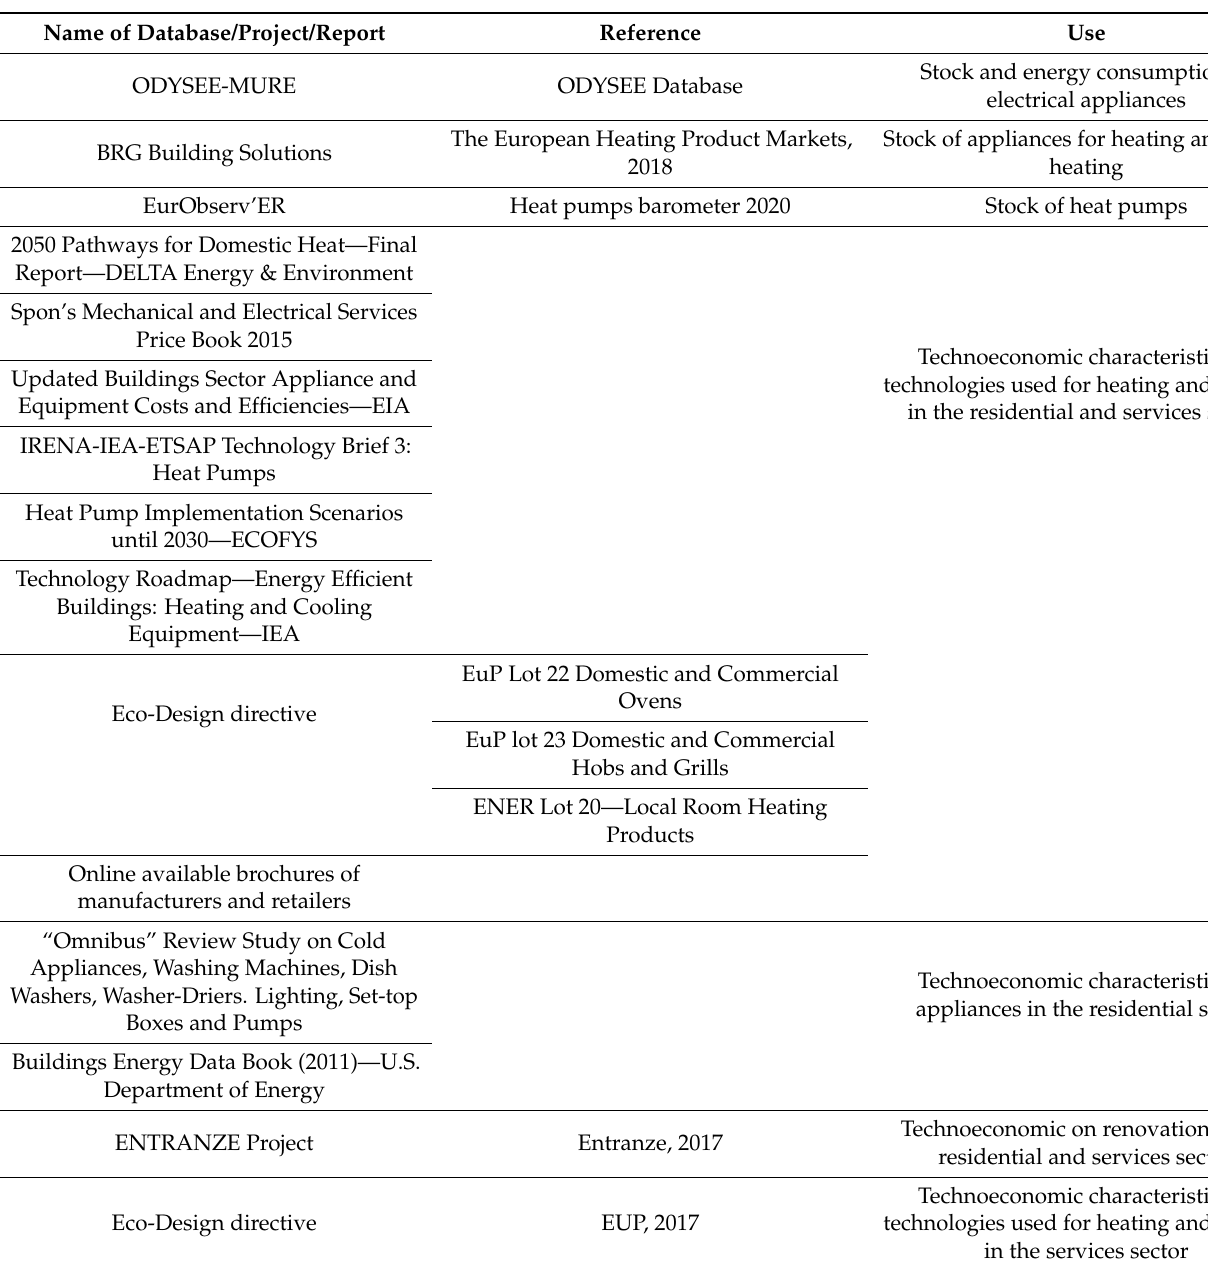
Table A2. List of databases, projects, and reports we combined and elaborated to build the database for the PRIMES-BuiMo stock, energy consumption, and technoeconomic characteristics of the